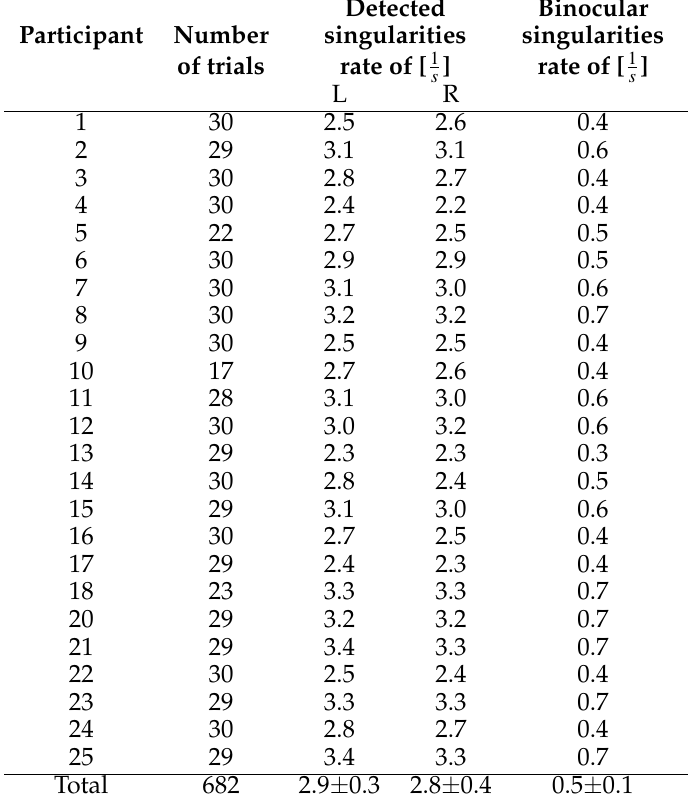
Rates for the detected monocular and binocular singularities in the surrogates of horizontal fixational eye movement data sets. The total rates are given as mean ± standard